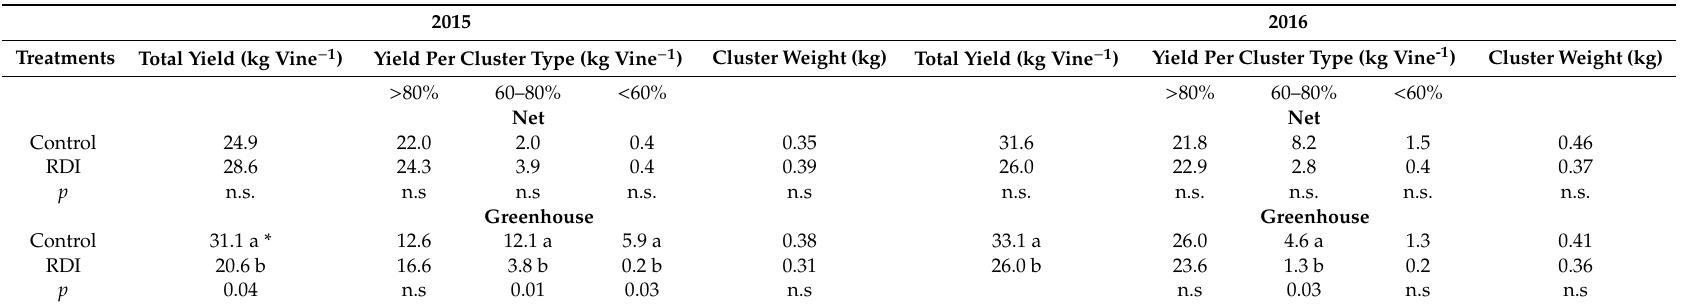
Table 3. Yield in response to irrigation treatments (Control and regulated deficit irrigation (RDI)) in vines grown under net and under a plastic greenhouse, in the 2015 and 2016 seasons. Cluster type: well-colored cluster, with more than 80% well colored berries ( > 80%); non-well-colored cluster, with 60–80% well colored berries (60–80%); and noncommercial clusters (harvested only in the last picking operation) ( <